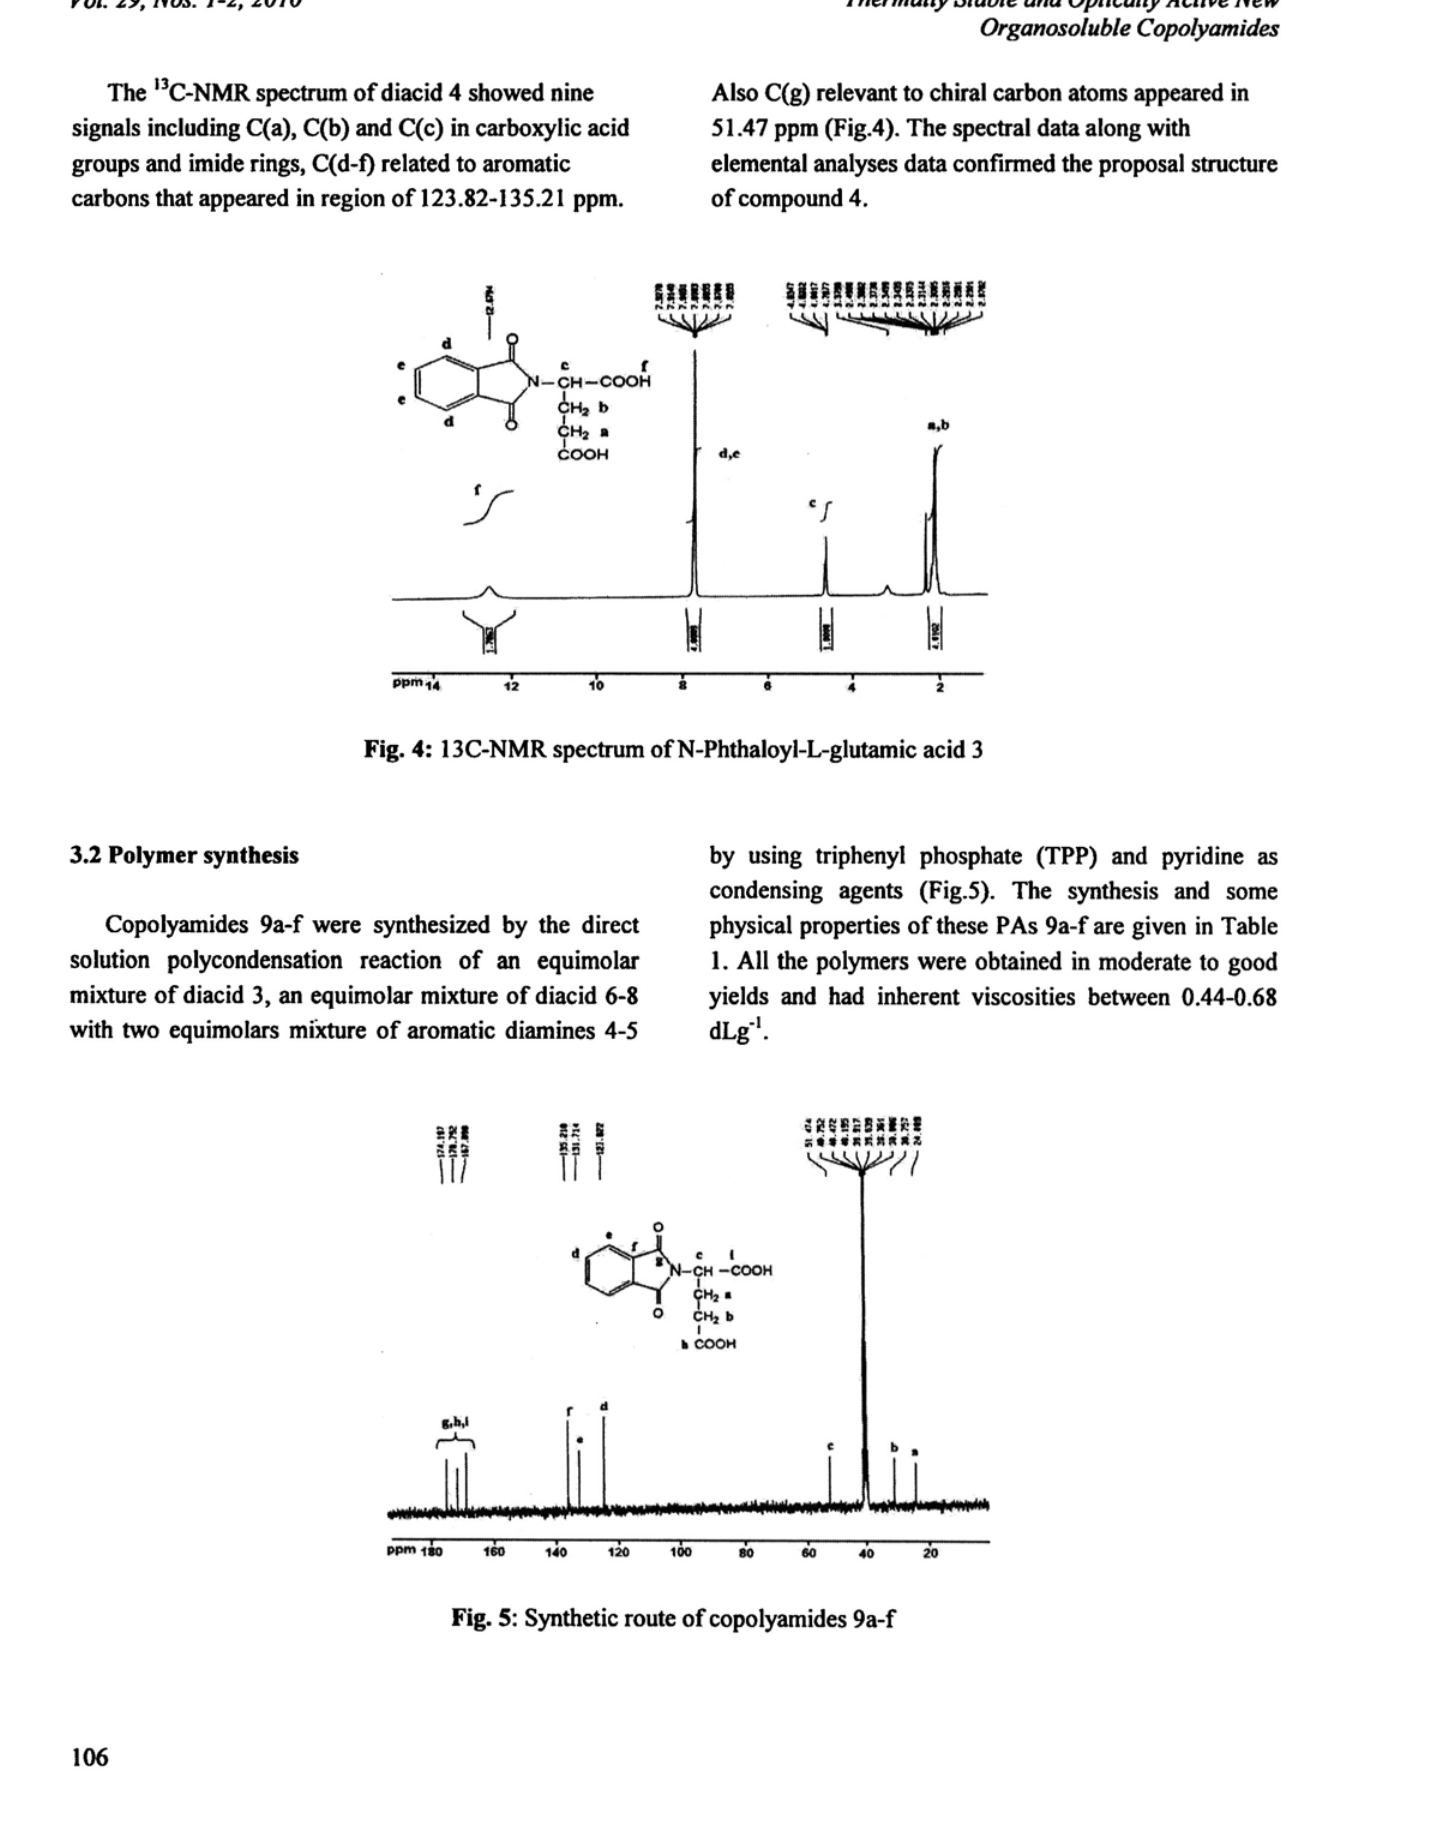
Fig. 5: Synthetic route of Copolyamides